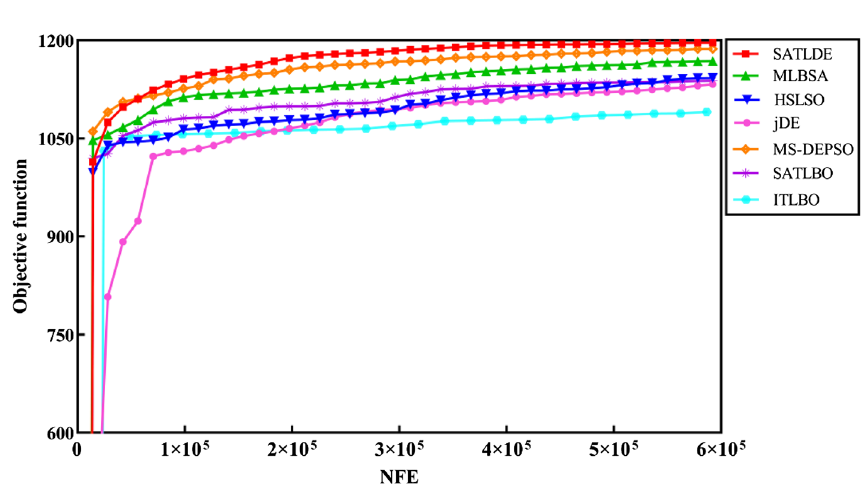
Figure 7. Boxplots of all optimizers for ten-reservoir problem.